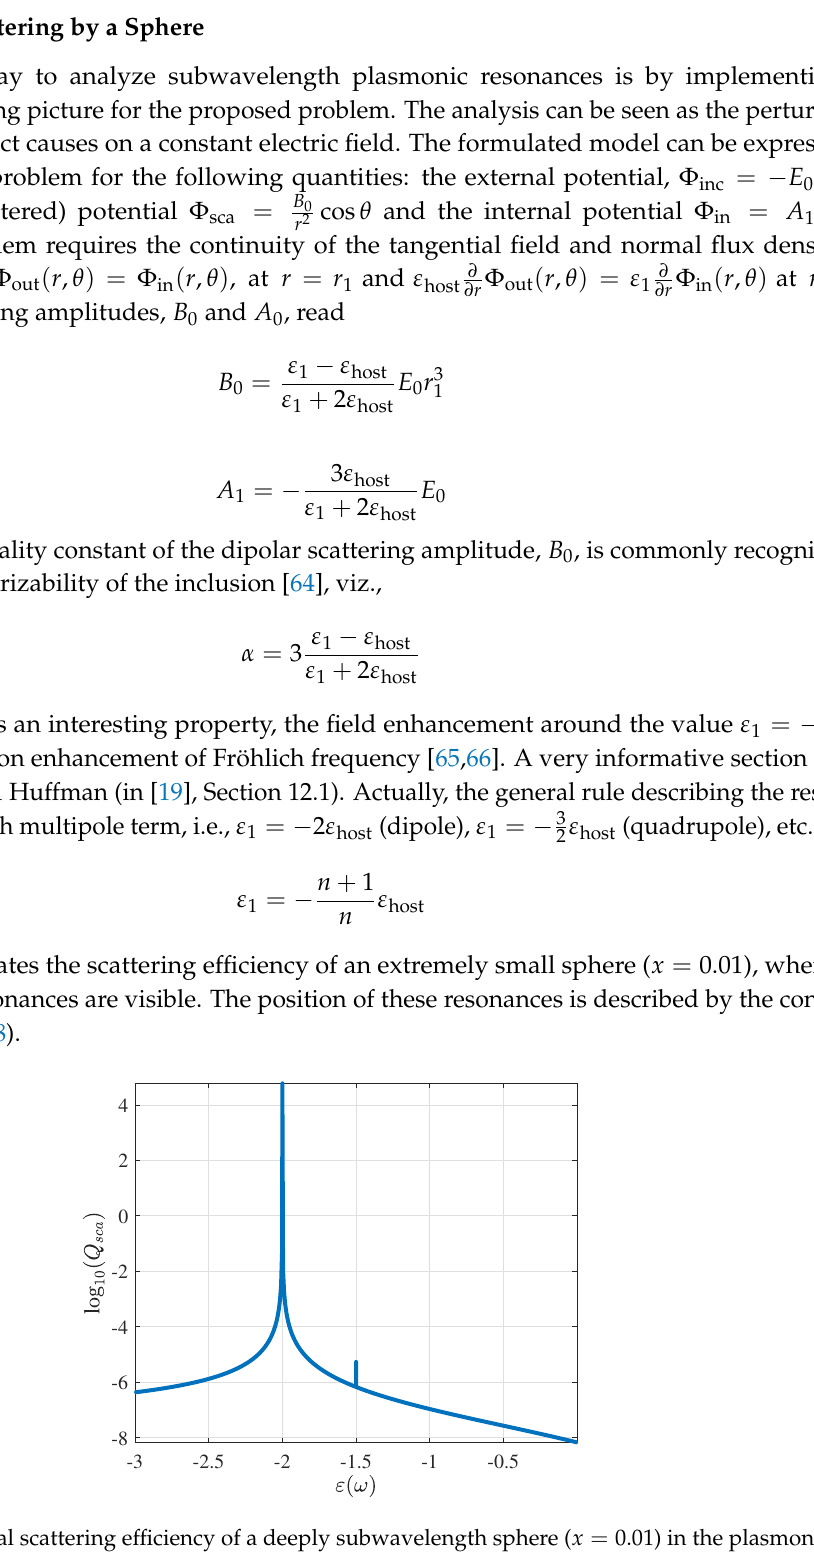
Figure 4. The total scattering efficiency of a deeply subwavelength sphere ( x = 0.01) in the plasmonic region. One main electric dipole resonance is observed at − 2, while a second ultra-sharp resonance at − 1.5. The field distribution for the dipolar resonance is characterized by a dipole-like external field, with a constant field at the inside domain of the sphere. This resonance can be seen in Figure 2 (inset